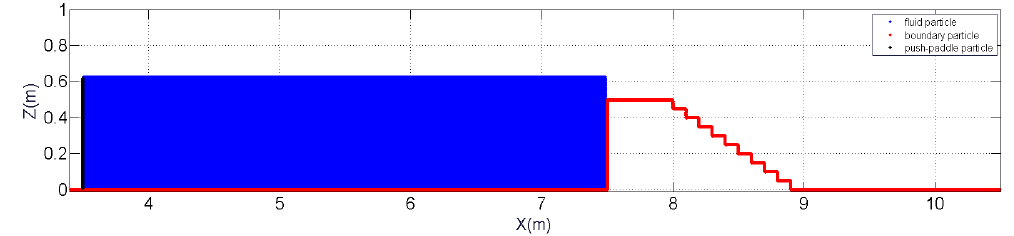
Figure 3. Schematic setup of computational domain for model validation.